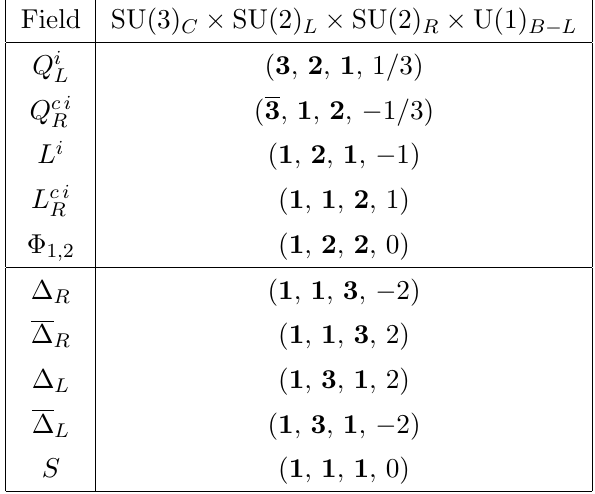
Table 1 . Matter contents and the charge assignment of the SU(2) R (cid:2) U(1) B (cid:0) L model. and discuss the mass terms for the Higgs doublets which are associated with the SU(2) breaking,